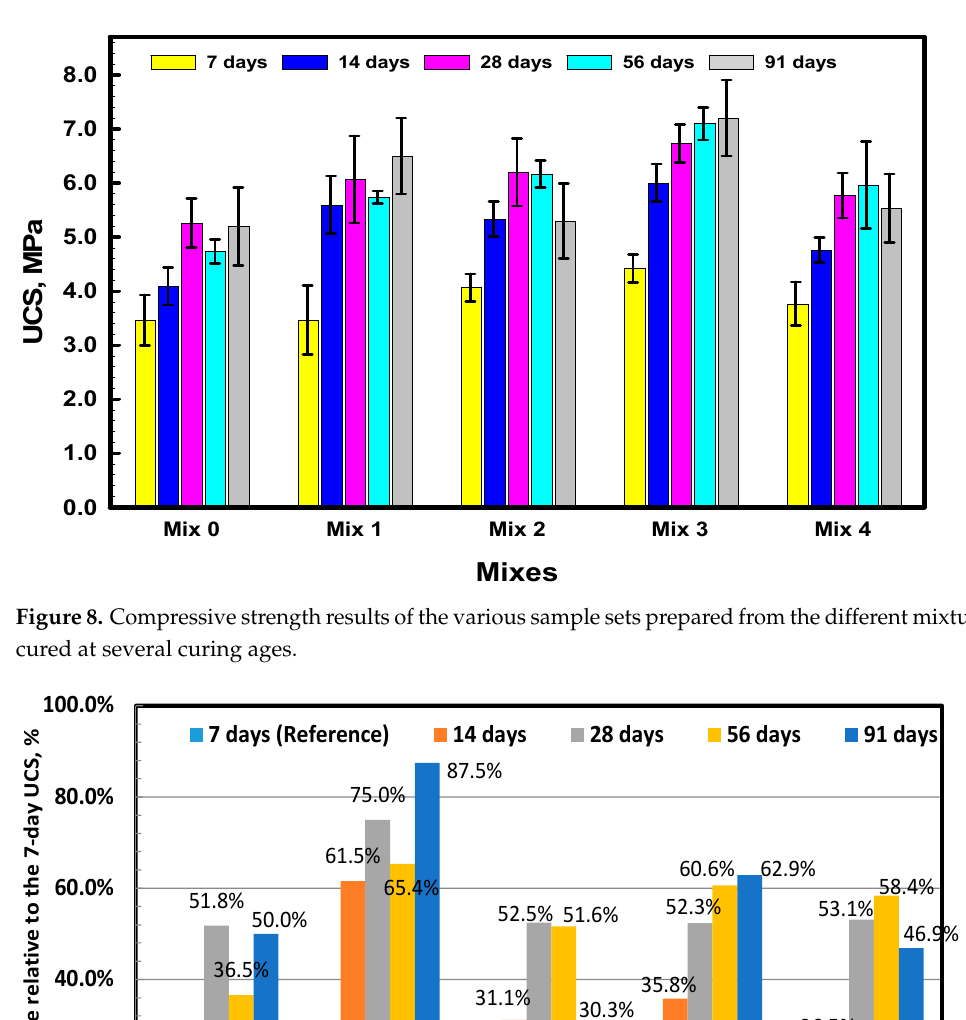
Figure 8. Compressive strength results of the various sample sets prepared from the different mixtures cured at several curing ages.